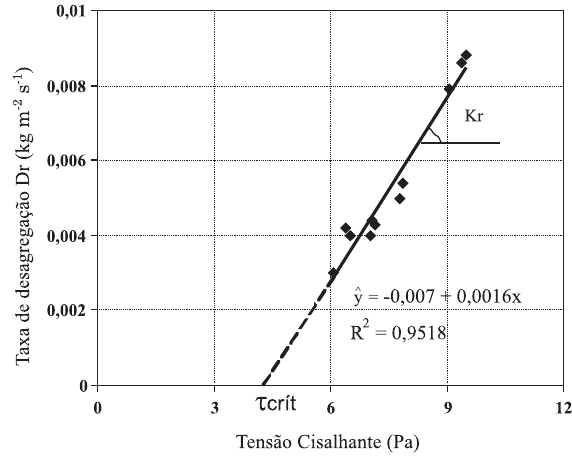
Figura 4. Relação entre a taxa de desagregação (Dr) e a tensão cisalhante ( τττττ ) nas ravinas e a erodibilidade do solo sob ravinas (K colocar kg Na lateral esquerda da